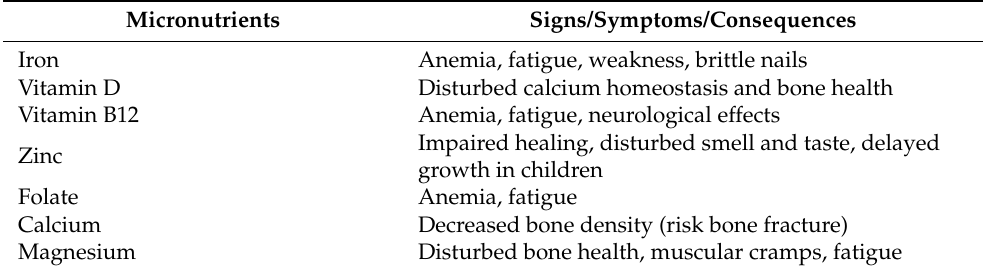
Table 1. Symptoms and signs of micronutrient deficiency.